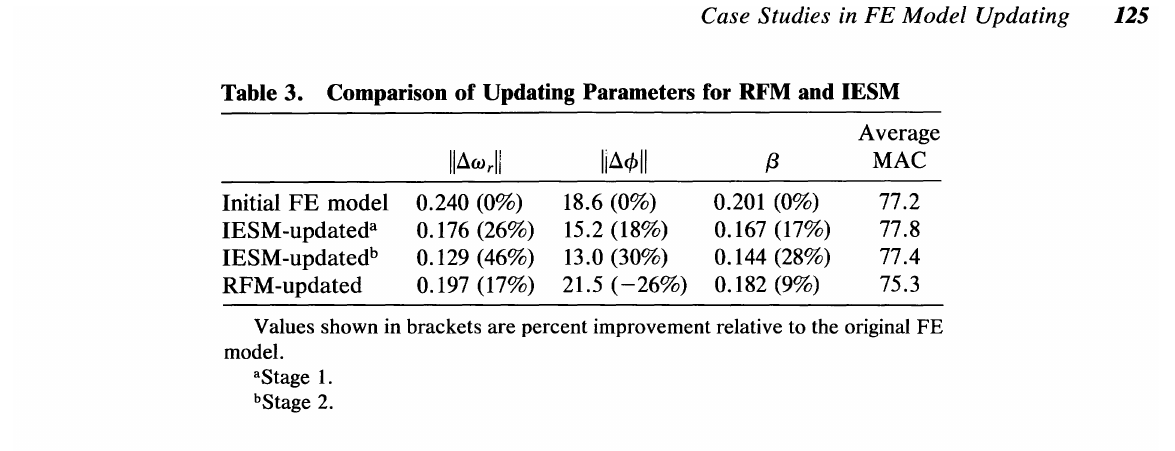
Table 3. Comparison of Updating Parameters for RFM and IESM